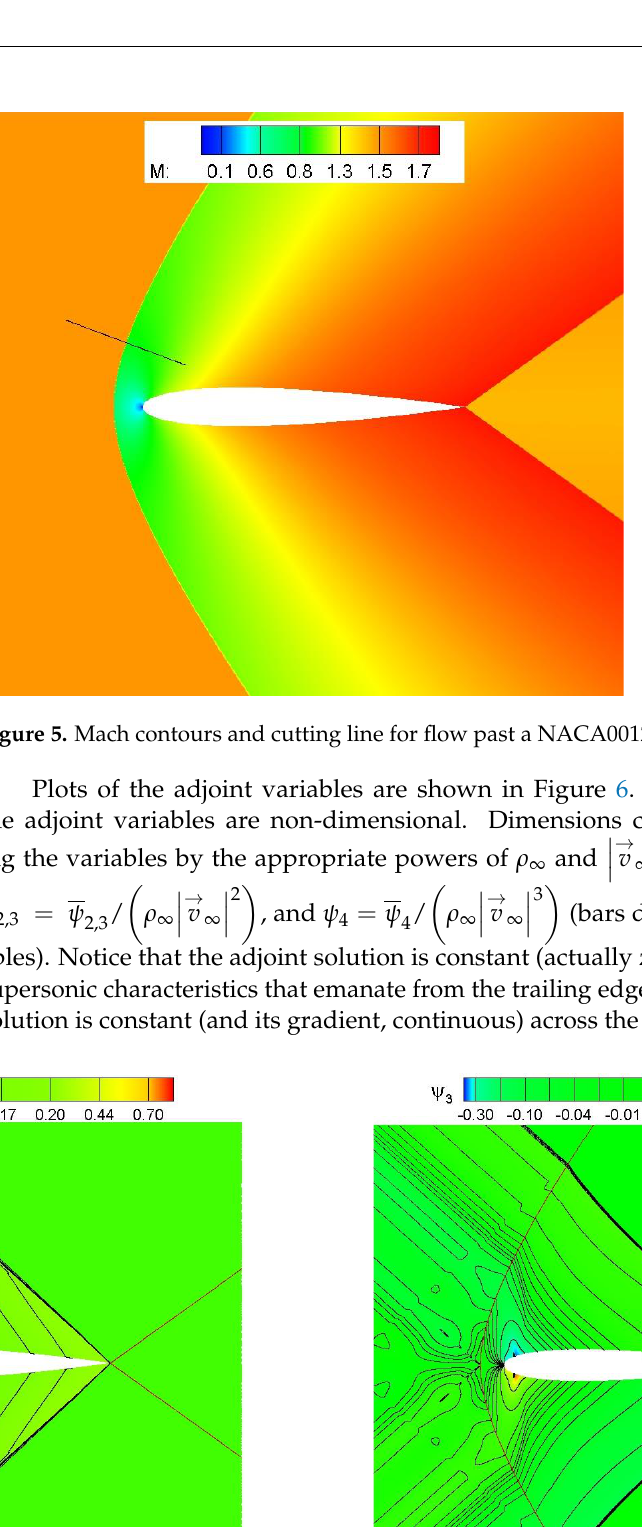
Figure 4. Close-up of the baseline NACA0012 mesh.